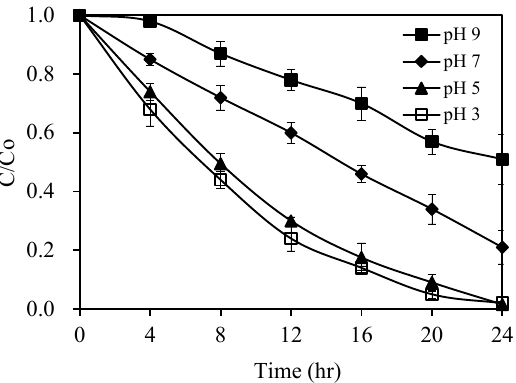
Figure 9. pH effect on the photocatalytic degradation rate of pirimicarb. Experimental conditions: pirimicarb concentration 10 mg L − 1 ; 1.0 wt% Pt / AgInS 2 concentration 1.0 g L − 1 . Error bars represent the standard deviations of duplicate runs.